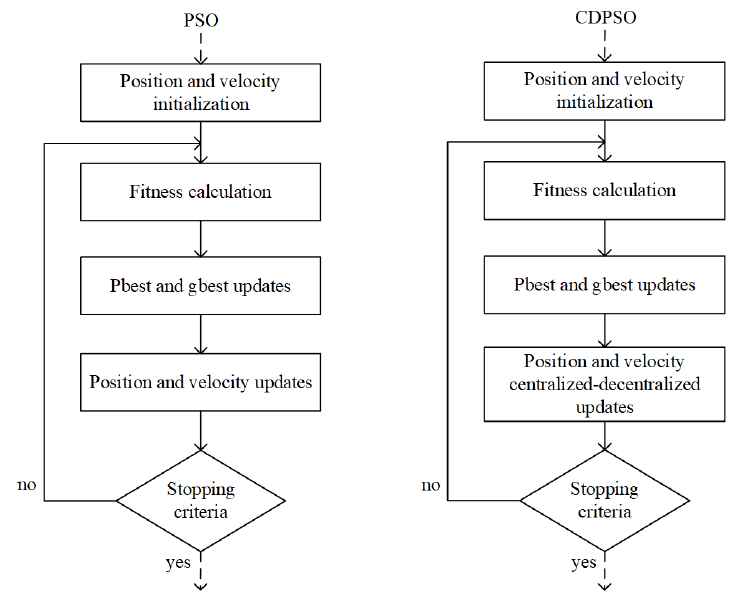
Figure 2. The flow charts of PSO, CDPSO, and